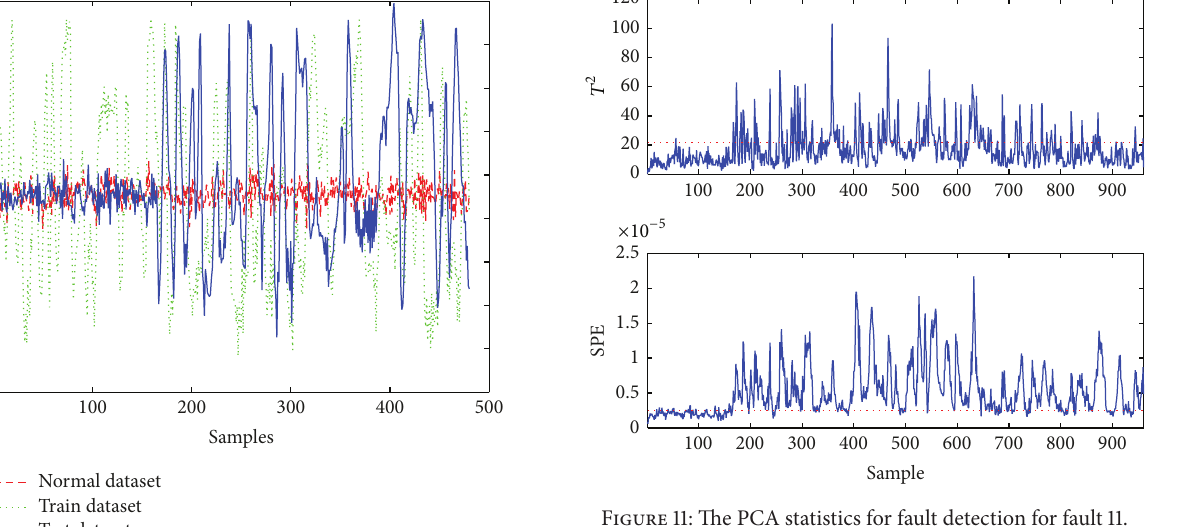
Figure 11: The PCA statistics for fault detection for fault